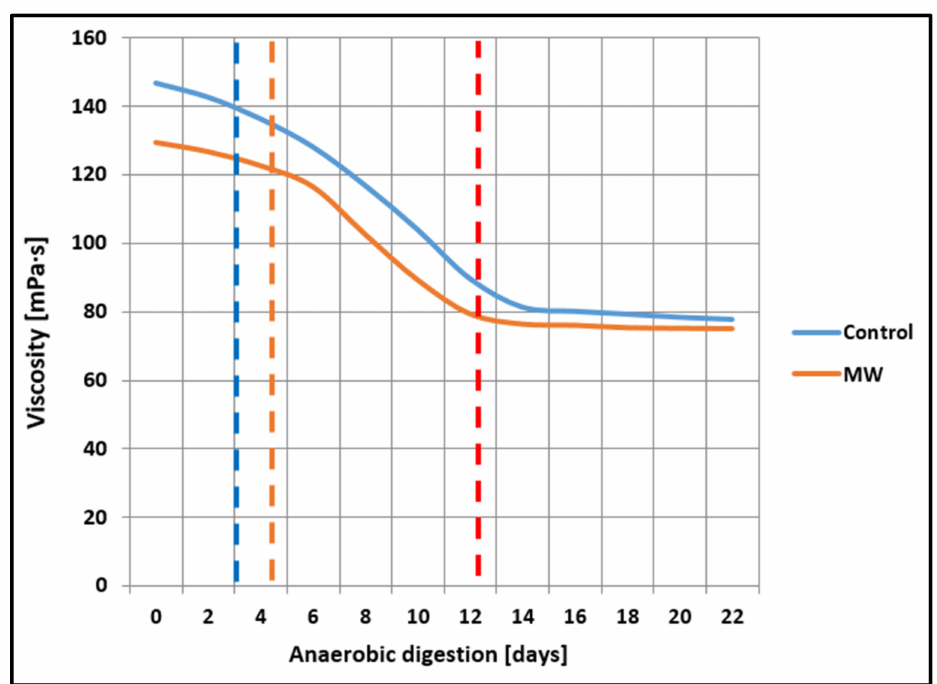
Figure 8. Change in absolute viscosity during the